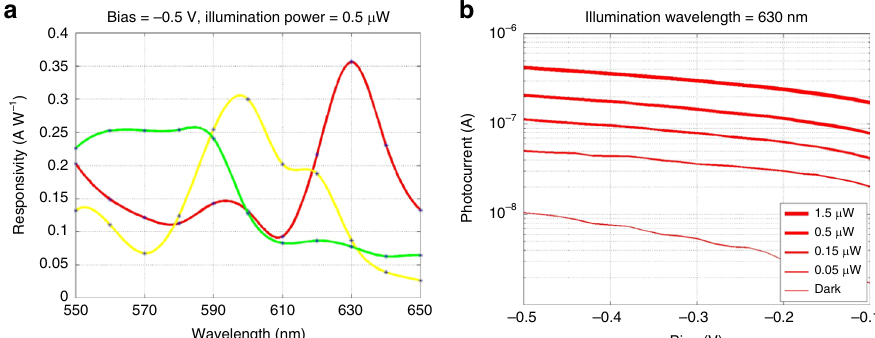
Fig. 4 Performance characteristics of CMOS color sensors based on anti-Hermitian metasurfaces. a Measured responsivity as a function of wavelength at reverse-bias of − 0.5 V and illumination power of 0.5 μ W for green, yellow, and red color channels. b Measured photocurrent as a function of reverse- bias in red color channel at illumination wavelength of 630 nm with illumination power parameterized. Source data for a and b are provided in the Source Data File tabs labeled a and b ,